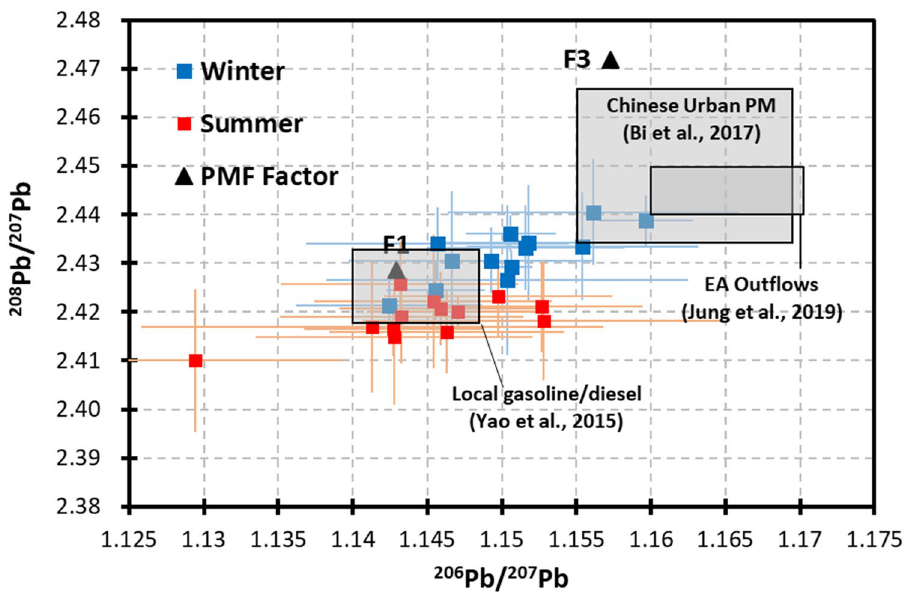
Figure 2. Distribution of the isotopic ratios of Pb in PM 2.5 in the summer and winter samples. Samples are collected at 13 sampling sites in central-western Taiwan during 5 field campaigns from 2016–2018, as described in the main text. The site-specific averages are denoted by symbols with ranges of ± 1 standard deviation, as shown by the error bars. The isotopic ratios of 2 PMF factors (F1 and F3) are denoted by triangles, whereas the other factors are beyond the ranges of this plot. The ranges of the isotopic ratios for fuels supplied in Taiwan, Chinese urban particulate matter and PM 2.5 transported by EA outflows are indicated with gray squares, with relevant references